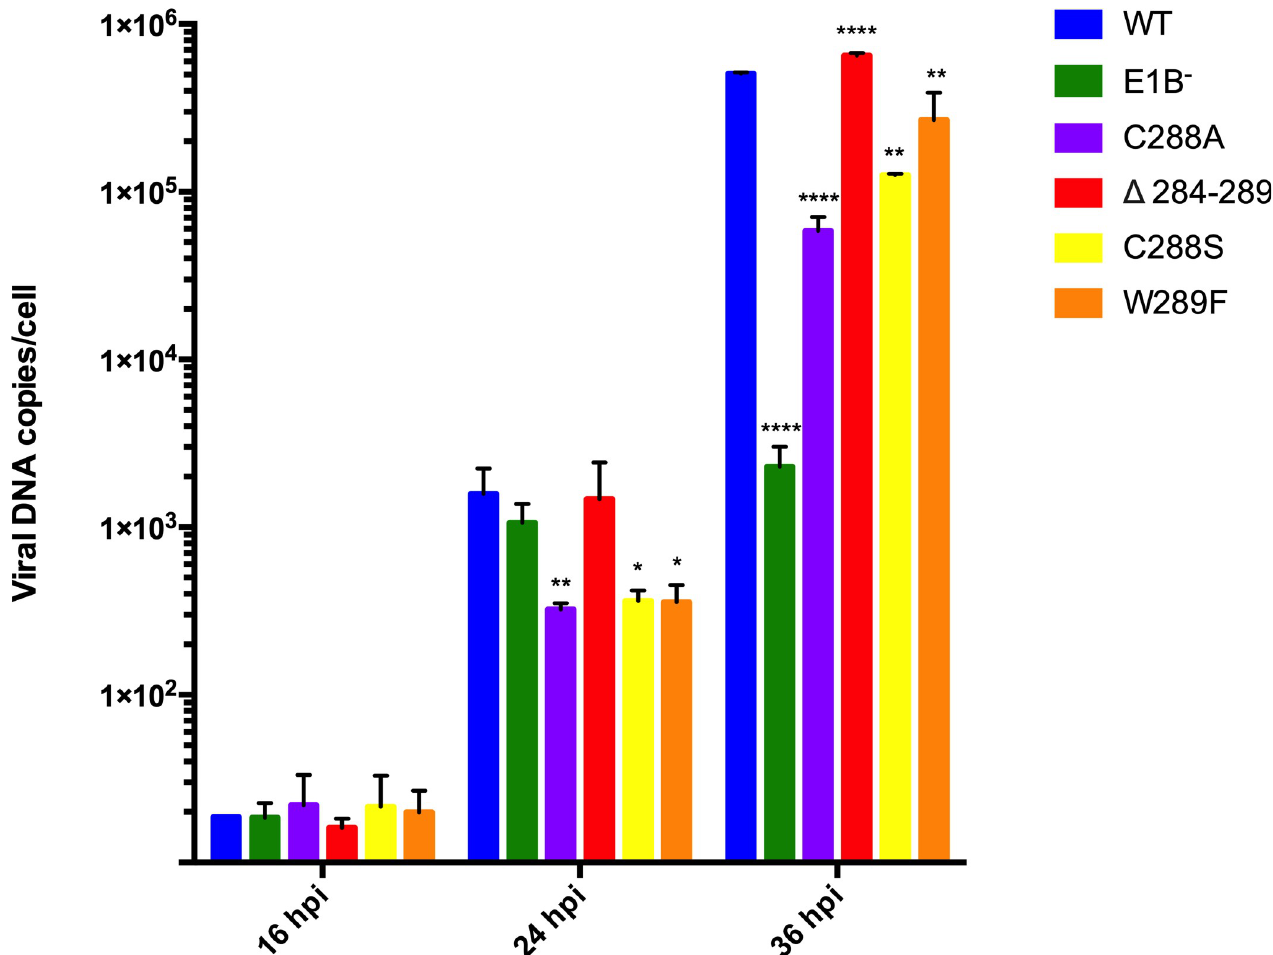
Fig 7. Kinetics of viral DNA accumulation are altered by mutations of the E1B 55K RNP motif. HFF cells infected with Ad5 WT or E1B 55K mutants were harvested at 16, 24 and 36 hpi and total DNA was isolated. Viral DNA was amplified through a quantitative PCR and a viral DNA absolute quantification was performed. Data are shown as viral DNA copy number per cell of duplicate samples from two independent experiments. � p < 0.05, �� p < 0.01, �� p < 0.001, ���� p < 0.0001, t-test.